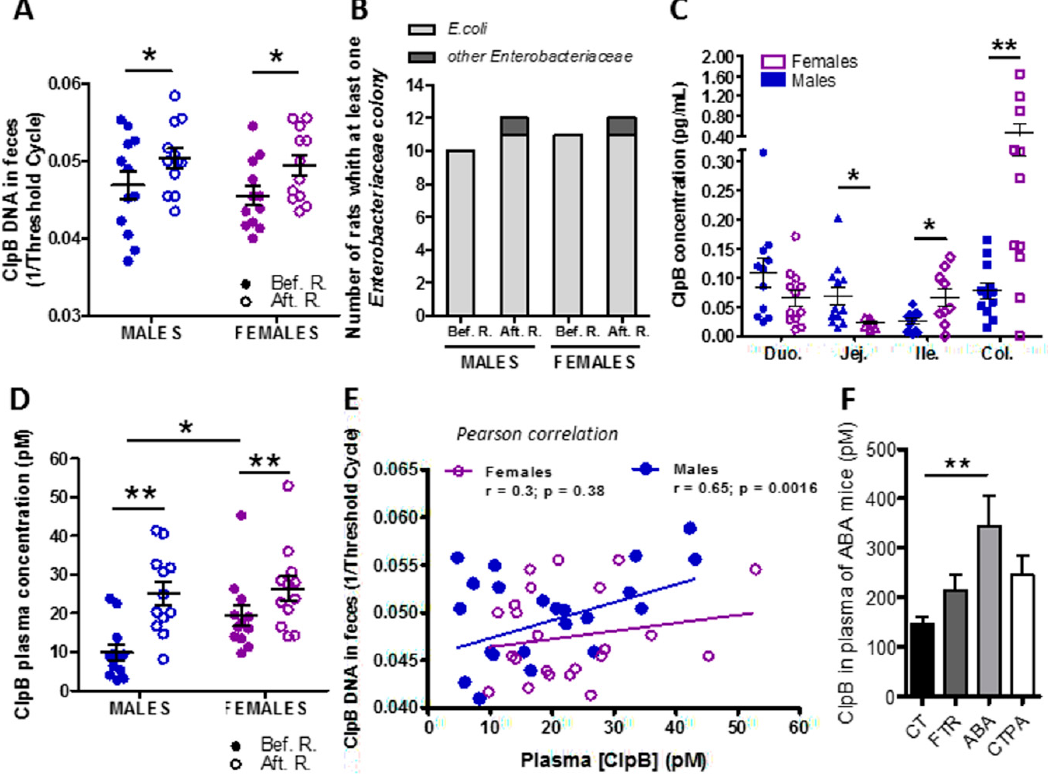
Figure 2. E ff ects of food restriction on ClpB production. ( A ) Fecal ClpB DNA levels before (solid circles) and 14 days after (empty circles) food restriction in male and female rats. ( B ) Biotyper identification of Enterobacteriaceae in fecal microbiota before (Bef.) and after (Aft.) restriction (R.) in female and male rats. ( C) ClpB protein concentration in the intestinal mucosa at the levels of the duodenum (Duo), jejunum (Jej), ileum (Ile), and colon (Col) in male (solid symbols) and female (empty symbols) rats after food restriction. ( D ) ClpB protein plasma concentration before (solid circles) and 14 days after (empty circles) food restriction in male and female rats. ( E ) Correlations between fecal ClpB DNA and plasma ClpB after food restriction in male (solid circles) and female (empty circles) rats. ( F ) Plasma levels of ClpB protein in male mice with activity-based anorexia (ABA) as compared to ad libitum-fed controls (CT) and feeding time-restricted (FTR) mice, plasma samples available from a previous study [18]. ( A ) 2-way ANOVA, time interaction * p = 0.02. ( C ) Students t-test * p < 0.05, ** p < 0.01. ( D ) 2-way ANOVA, time (** p = 0.001) and row Factor (* p = 0.04). ( F ) 1-way ANOVA, Bonferroni’s post-test * p < 0.05, ** p < 0.01.